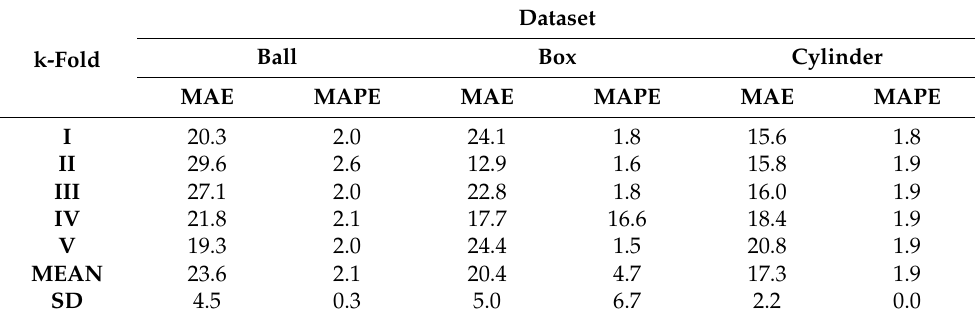
Table 4. The results from experiments on shape-invariant estimation of the stiffness parameter using ConvBiLSTMNet.